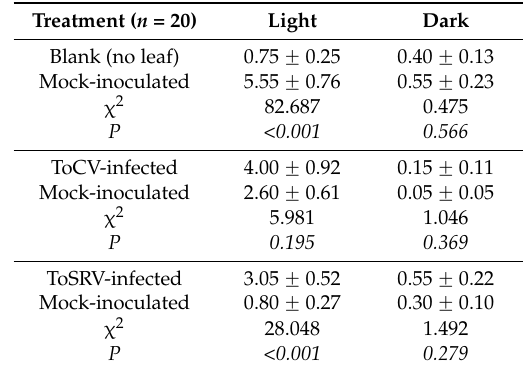
Table 2. Bemisia tabaci adult choice * (mean ˘ SE) in dual-choice arena with no active airflow under light and dark